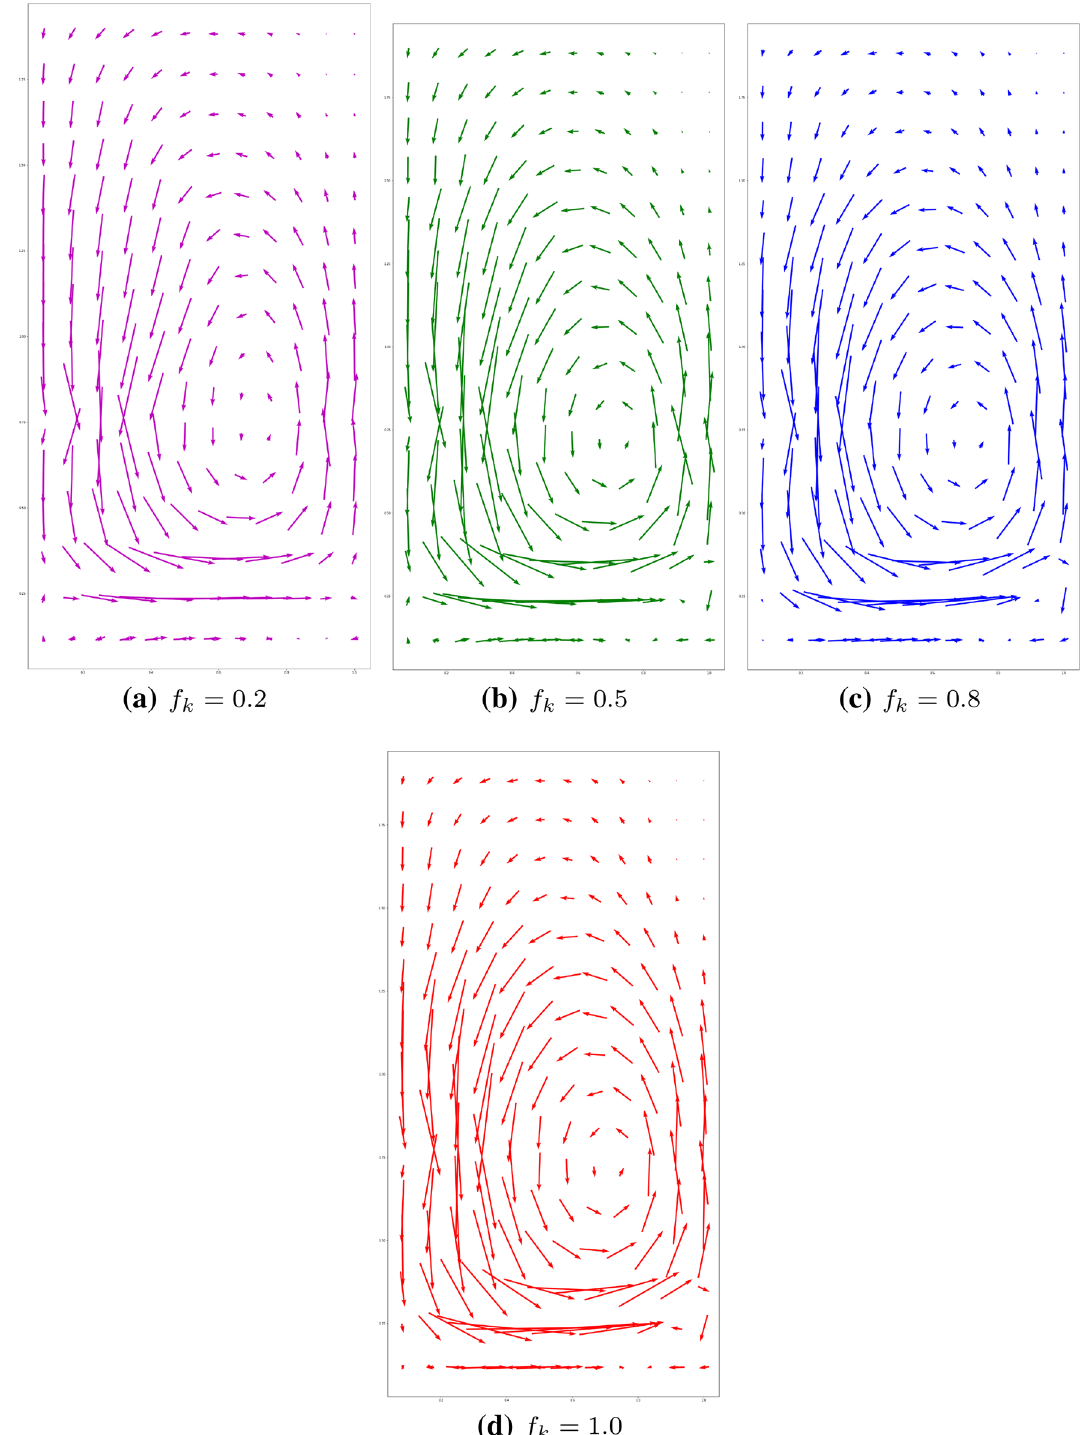
Fig. 14 Flow visualisation of the domain after computation for different f k by using PANS k u − 𝜖 u − 𝜖 for all its f . PANS k model predicts more dissipation u u k = 0.2 bellow and away from the impeller and rate for f k the prediction of dissipation rate is higher for f = 0.2 just above the impeller. The prediction of all the f k